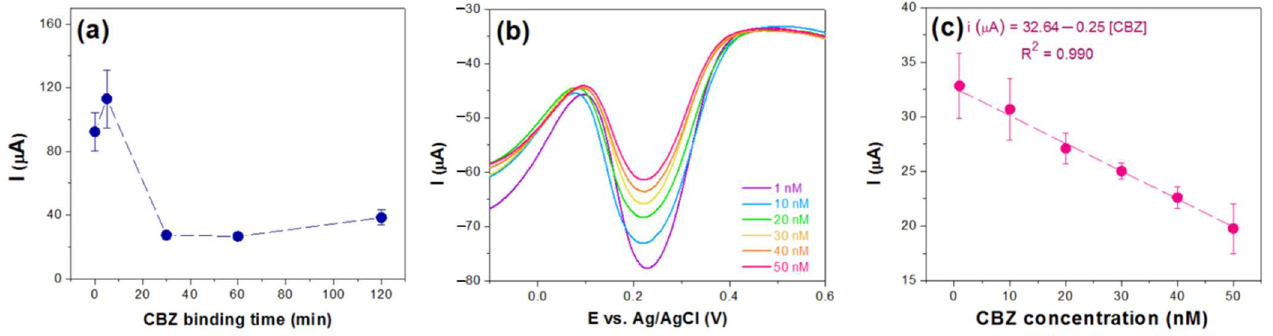
Figure 3. ( a ) Influence of the CBZ incubation time on the aptasensor; ( b ) DP voltammograms of 1.0 mM CBZ in 0.1 M PBS (pH 7.4) with different concentrations of CBZ; ( c ) calibration plot of ( b ). All measurements were performed in triplicate.